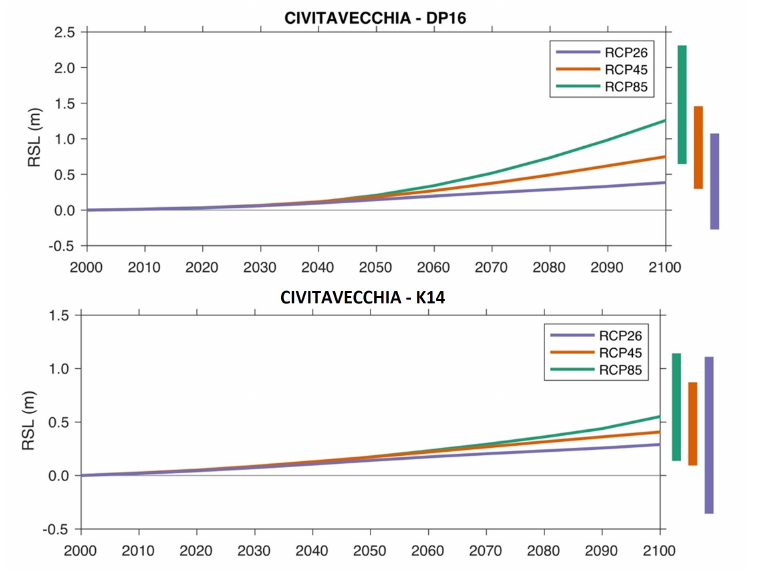
Figure 4. Downscaled projections used to calculate the total probability of sea level rise D16 ( top ) and K14 ( bottom ).